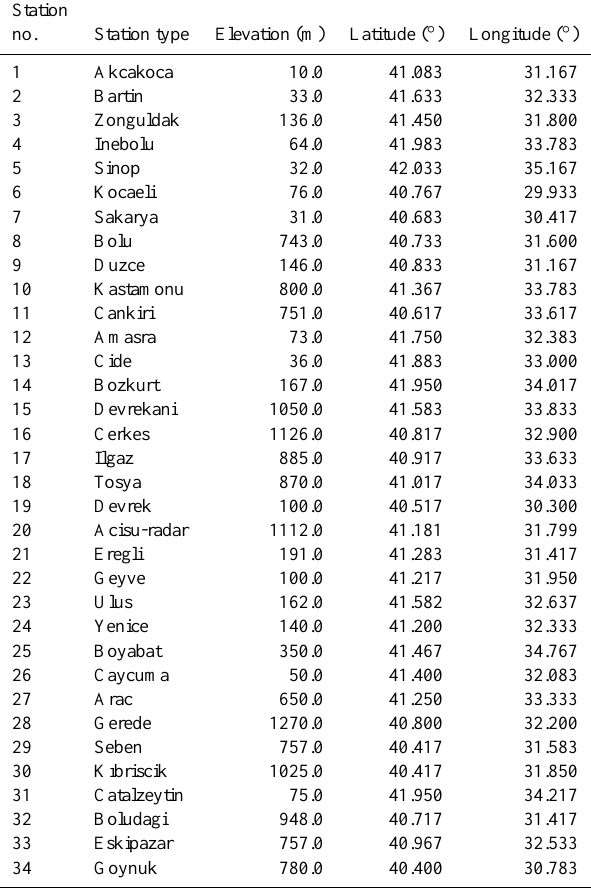
Table 2. The name, elevation, latitude, and longitude of automated rain gauge stations of MGM used in this study. Station